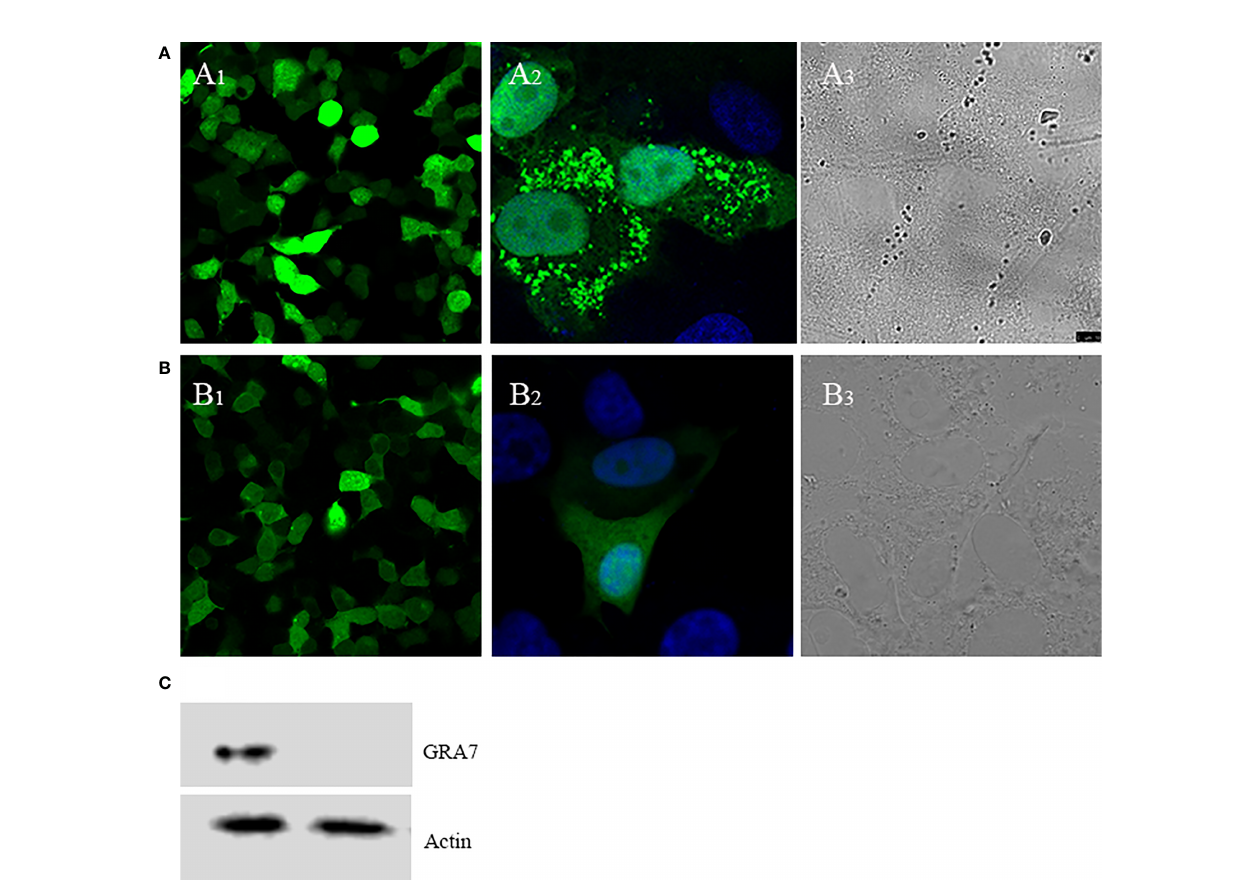
FIGURE 1 | Direct fl uorescence detection of the GRA7-EGFP-C2 fusion protein in transfected Vero cells. (A) Cells transfected with GRA7-pEGFP-C2 were detected under blue light (A1) ; the localization of GRA7 in Vero cells was observed under blue light (A2) and white light (A3) . (B) Cells transfected with pEGFP-C2 were detected under blue light (B1) ; single cells transfected with pEGFP-C2 were observed under blue light (B2) and white light (B3) . (C) Western blot analysis of GRA7 protein recognized by anti- Toxoplasma gondii mouse